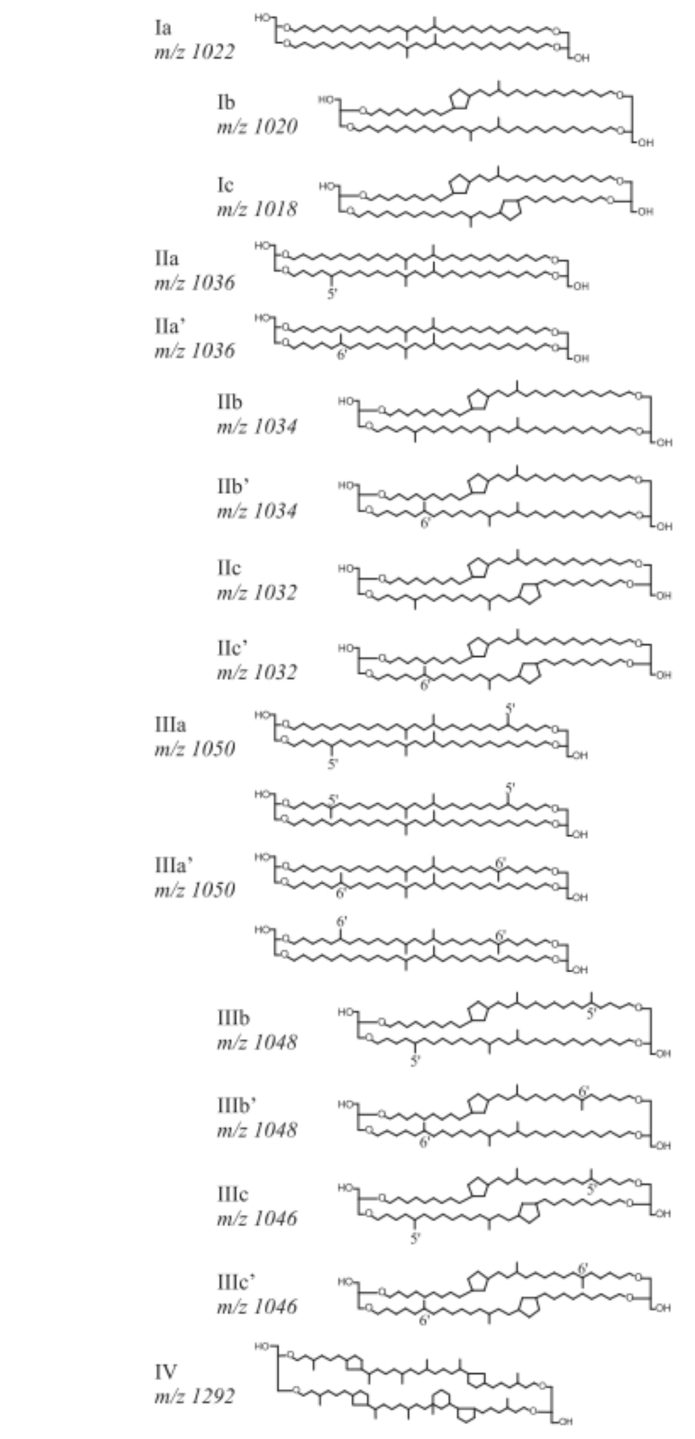
Figure A1. Chemical structures and molecular masses of brGDGTs, as described in De Jonge et al. (2014).